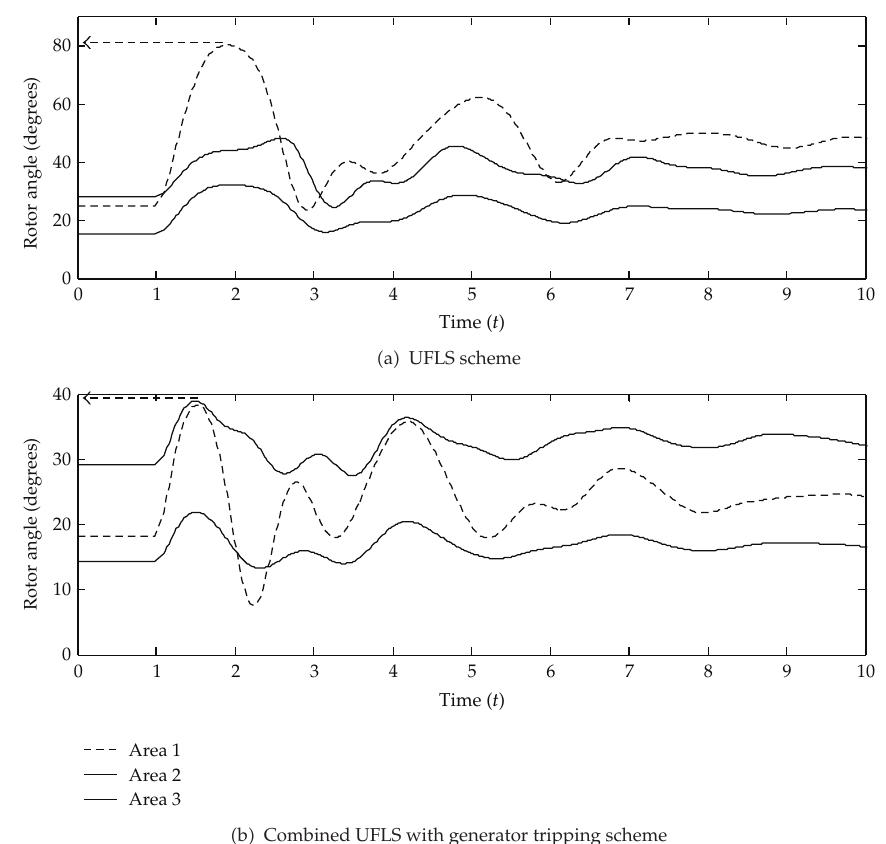
Figure 10: The system remains stable after applying both